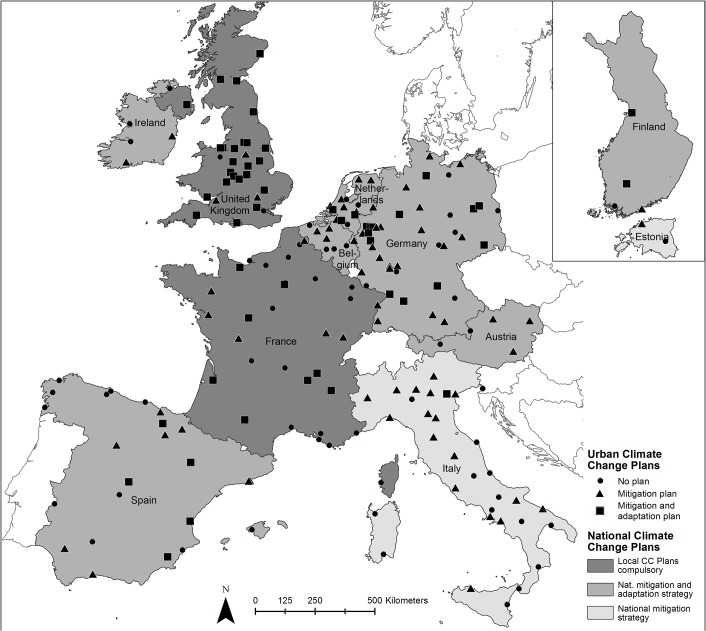
Distribution of climate change adaptation and mitigation plans across European cities, their respective national strategies.Fig 1 shows the location and distribution of cities and countries contained in the analysis. Cities are equally distributed within each country [69]. The sample covers a wide range of countries and climate regions across Europe. Pictograms indicate the location of cities surveyed and the existence of an urban mitigation plan or a mitigation and adaptation plan, if any (there was no city with an adaptation plan, only). Key: CC–climate change; nat.–national.